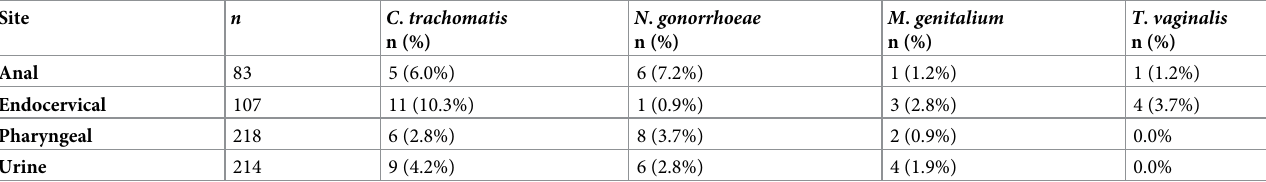
Table 4. Anatomical distribution and prevalence of the Allplex ™ -positive